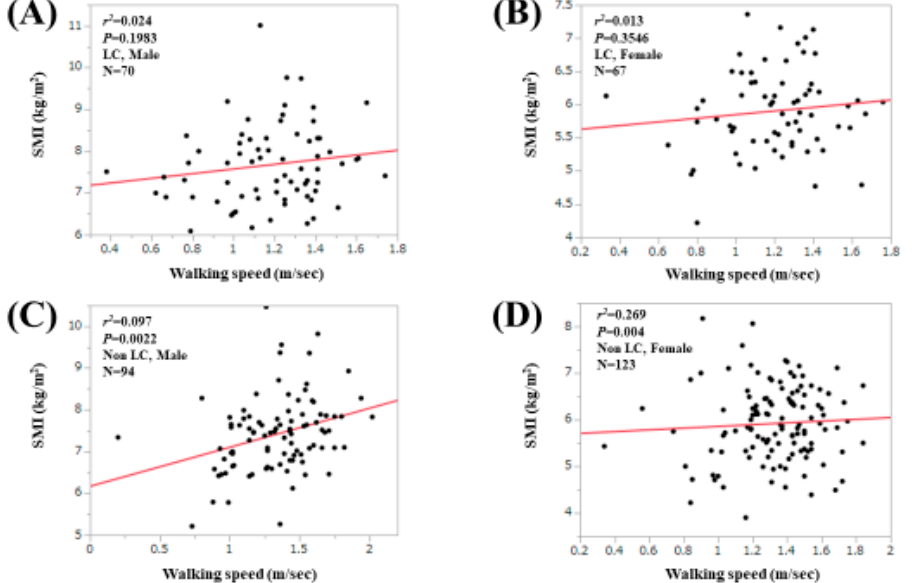
Figure 6. Correlation between the WS value and the SMI value in male LC patients ( A ) and in female LC patients ( B ). Correlation between the WS value and the SMI value in male non-LC patients ( C ) and in female non-LC patients ( D ).